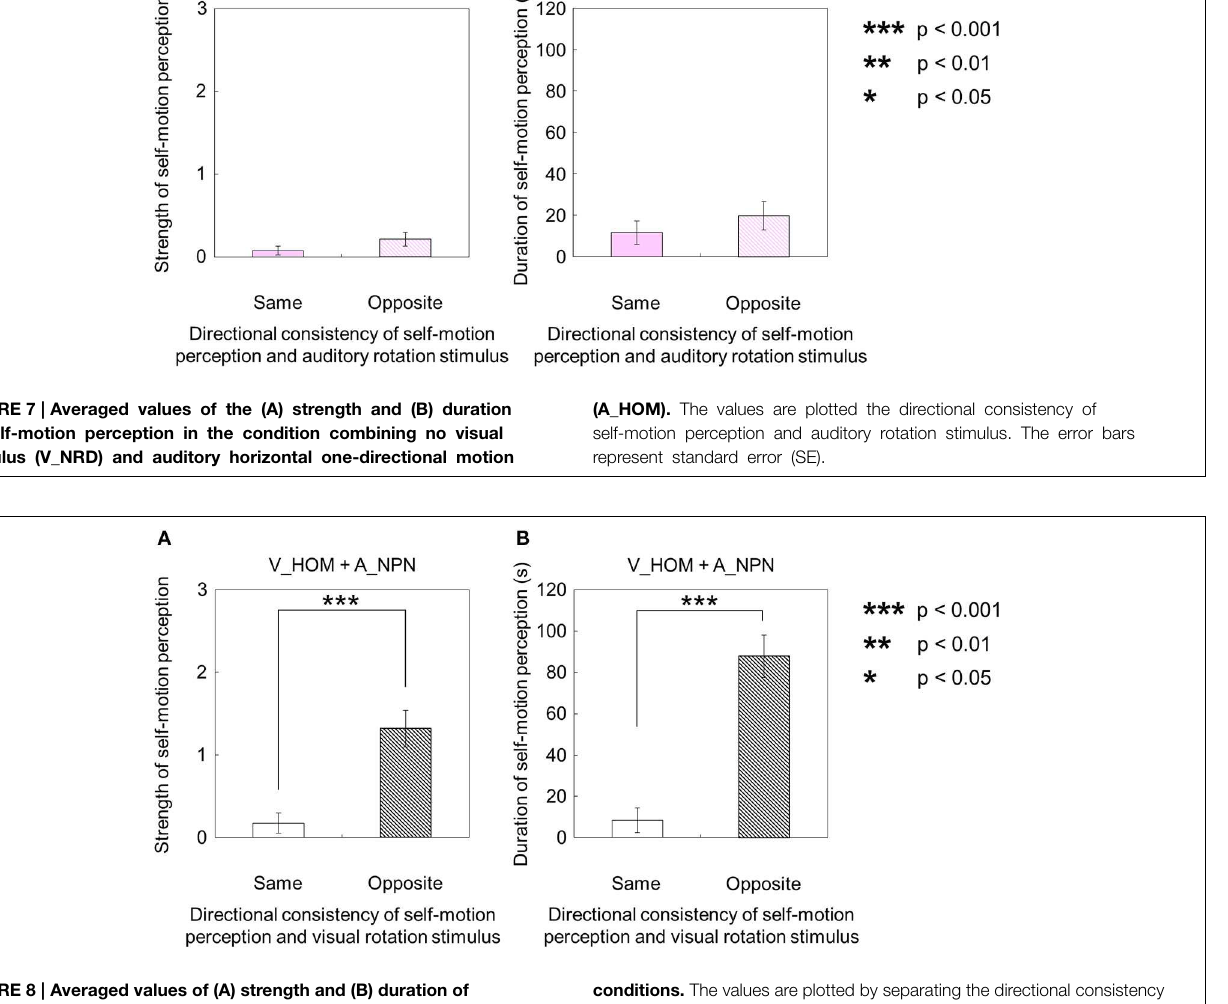
FIGURE 8 | Averaged values of (A) strength and (B) duration of self-motion perception in the condition combining visual horizontal one-directional motion (V_HOM) and no-auditory-stimulus (A_NPN)